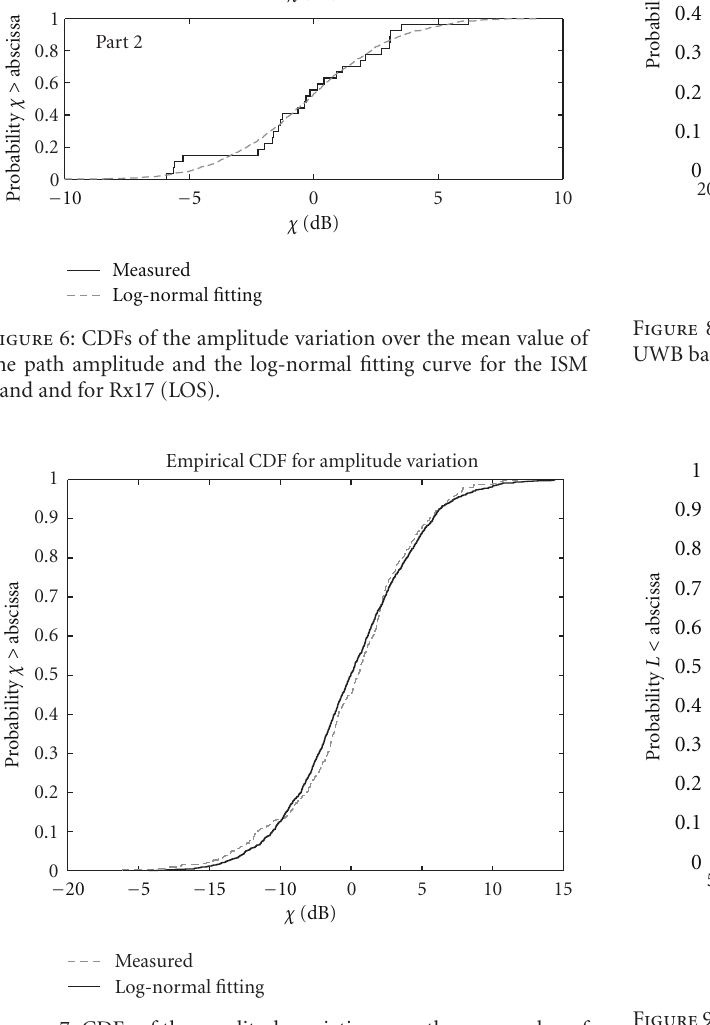
Figure 7: CDFs of the amplitude variation over the mean value of the path amplitude and the log-normal fitting curve for the UWB band and for Rx17 (LOS).